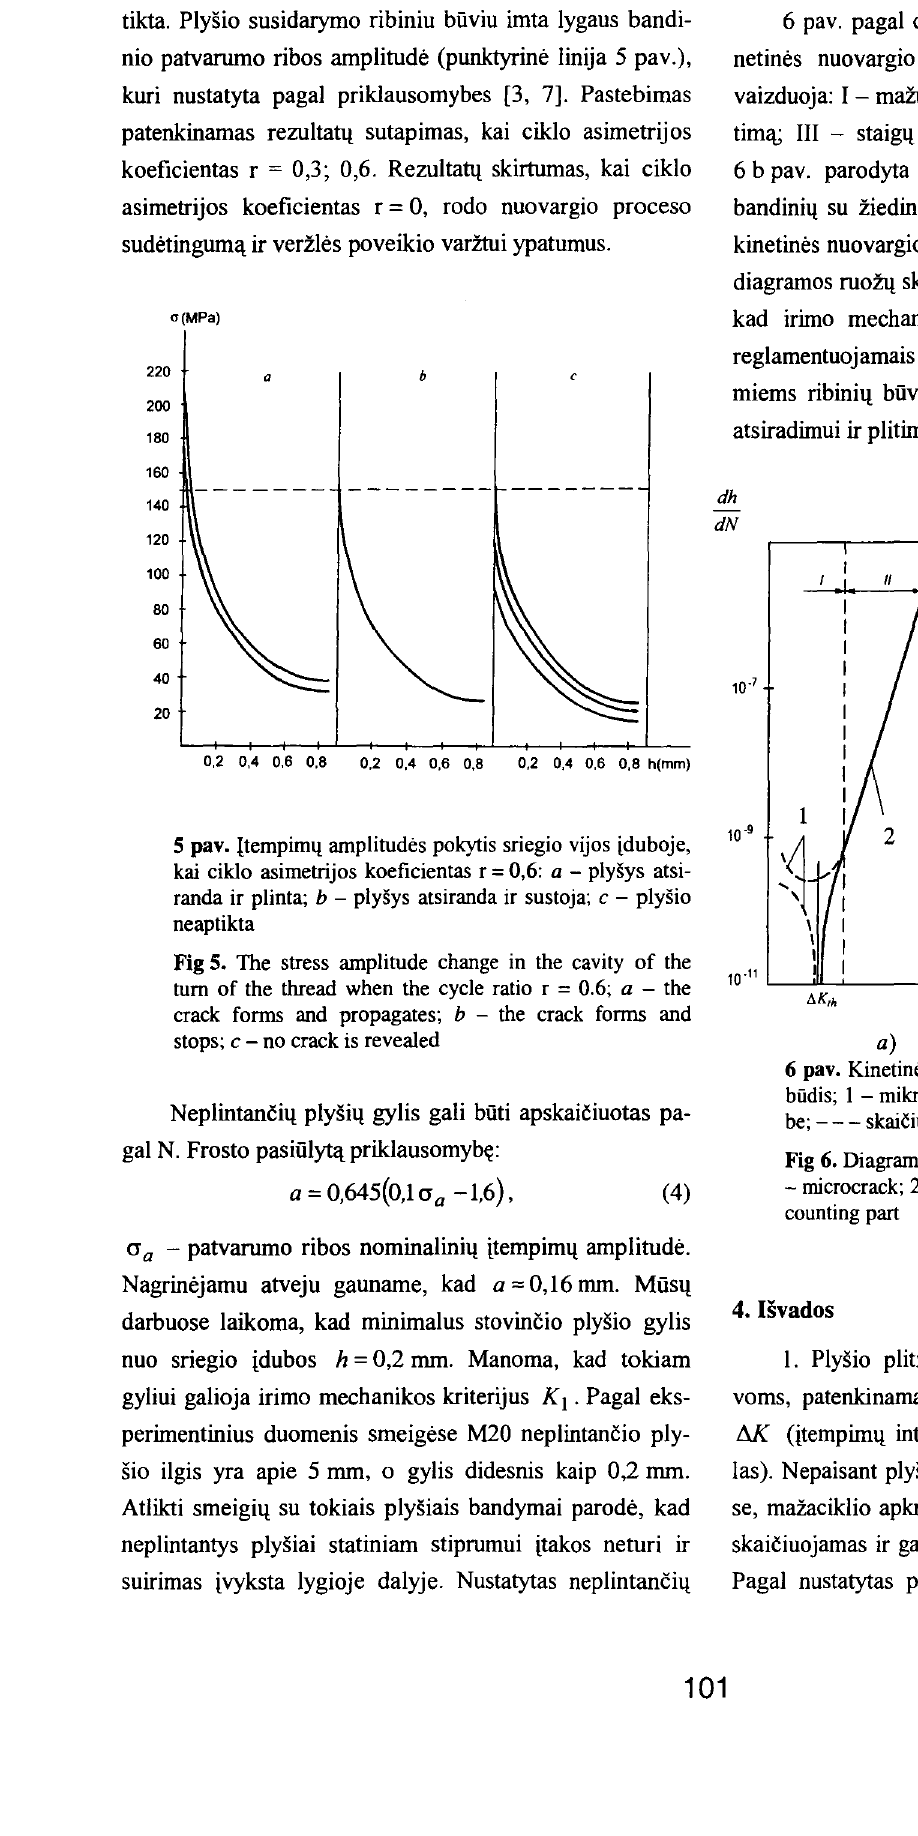
5 pav. parodytas itempimtt amplitudes pokytis sriegio vijos iduboje, atitinkantis tokius biivius: plysys atsiranda ir plinta; plysys atsiranda, taciau sustoja ir plysio neap tikta. Plysio susidarymo ribiniu biiviu imta lygaus bandi nio patvarumo ribos amplitude (punktyrine linija 5 pav.), kuri nustatyta pagal priklausomybes [3, 7]. Pastebimas